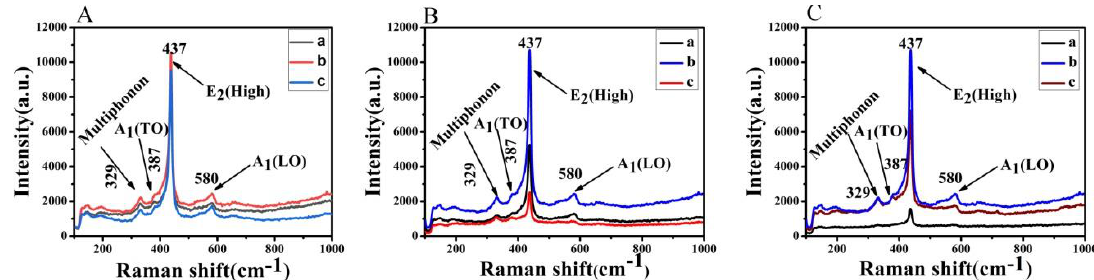
Figure 7. ( A ) Raman spectroscopy of ZnO grown at different solution concentrations: (a) 20 mmol/L,